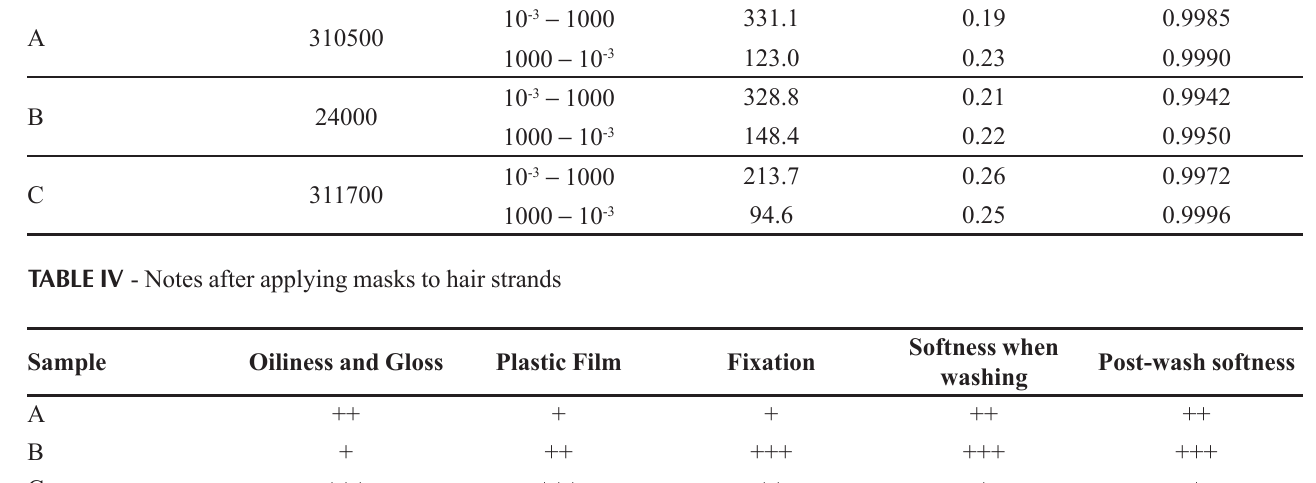
TABLE III - Rheological parameters Sample